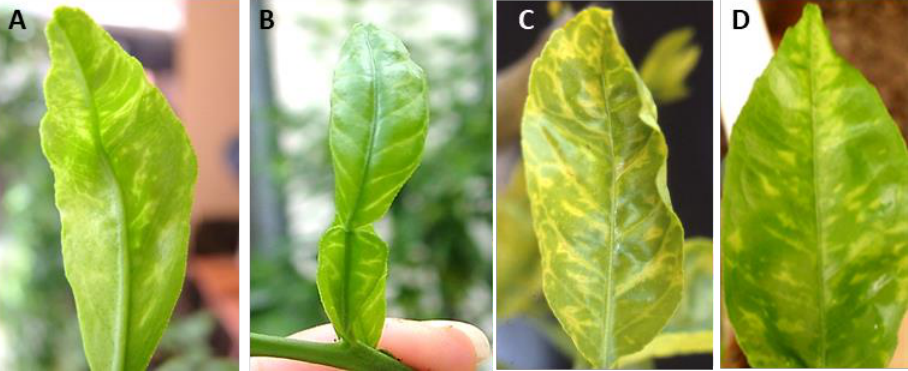
Figure 7. Leaf symptoms of citrus yellow vein clearing induced by inoculation of HU-PSTS on sour orange ( A , B ) and lemon ( C , D ) about 4–5 months post-inoculation. The HU-PSTS library shared a total of 12,772 read counts with two citrus tatter leaf virus genome references and generated a consensus sequence of almost 6495 nt in